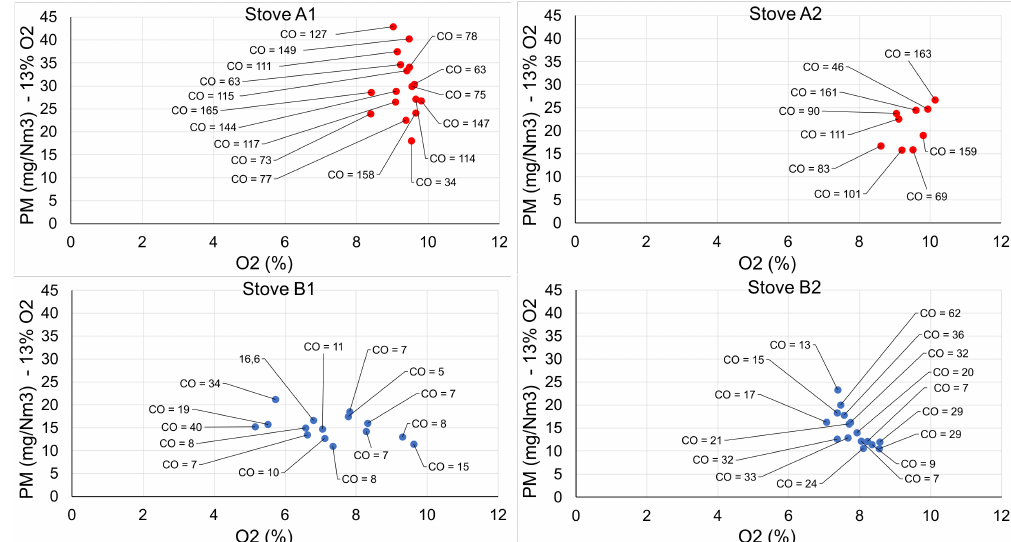
Figure 3. Average PM–O 2 –CO values for each test performed with stoves A1, A2, B1 andB2. CO – mg/Nm 3 at 13% ofO 2